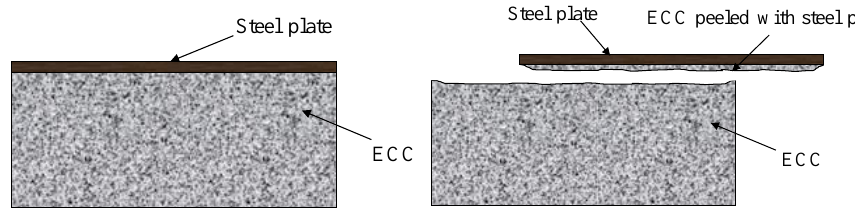
Figure 14. Schematic diagram of interfacial failure.